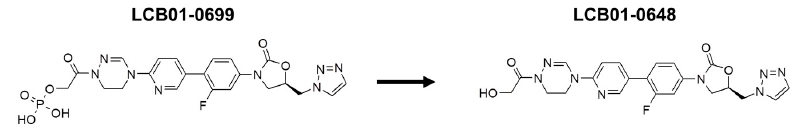
Figure 1. Chemical structures of LCB01-0648 and LCB01-0699 .